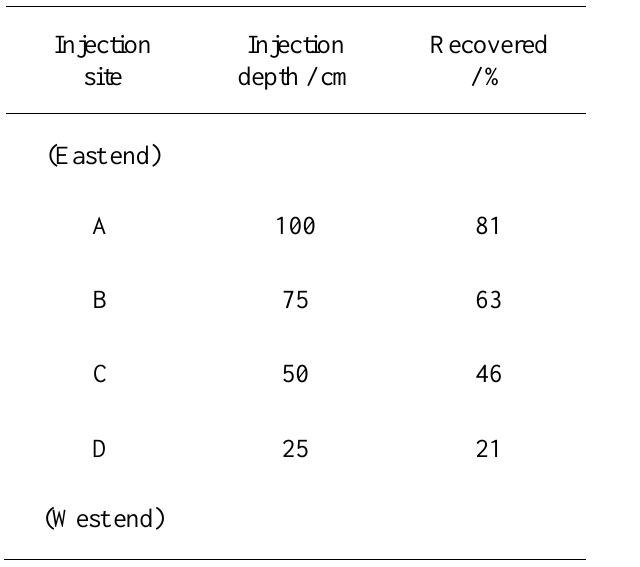
Table 1. Proportion of injected tritium accounted for after 24 years at the four injection sites.